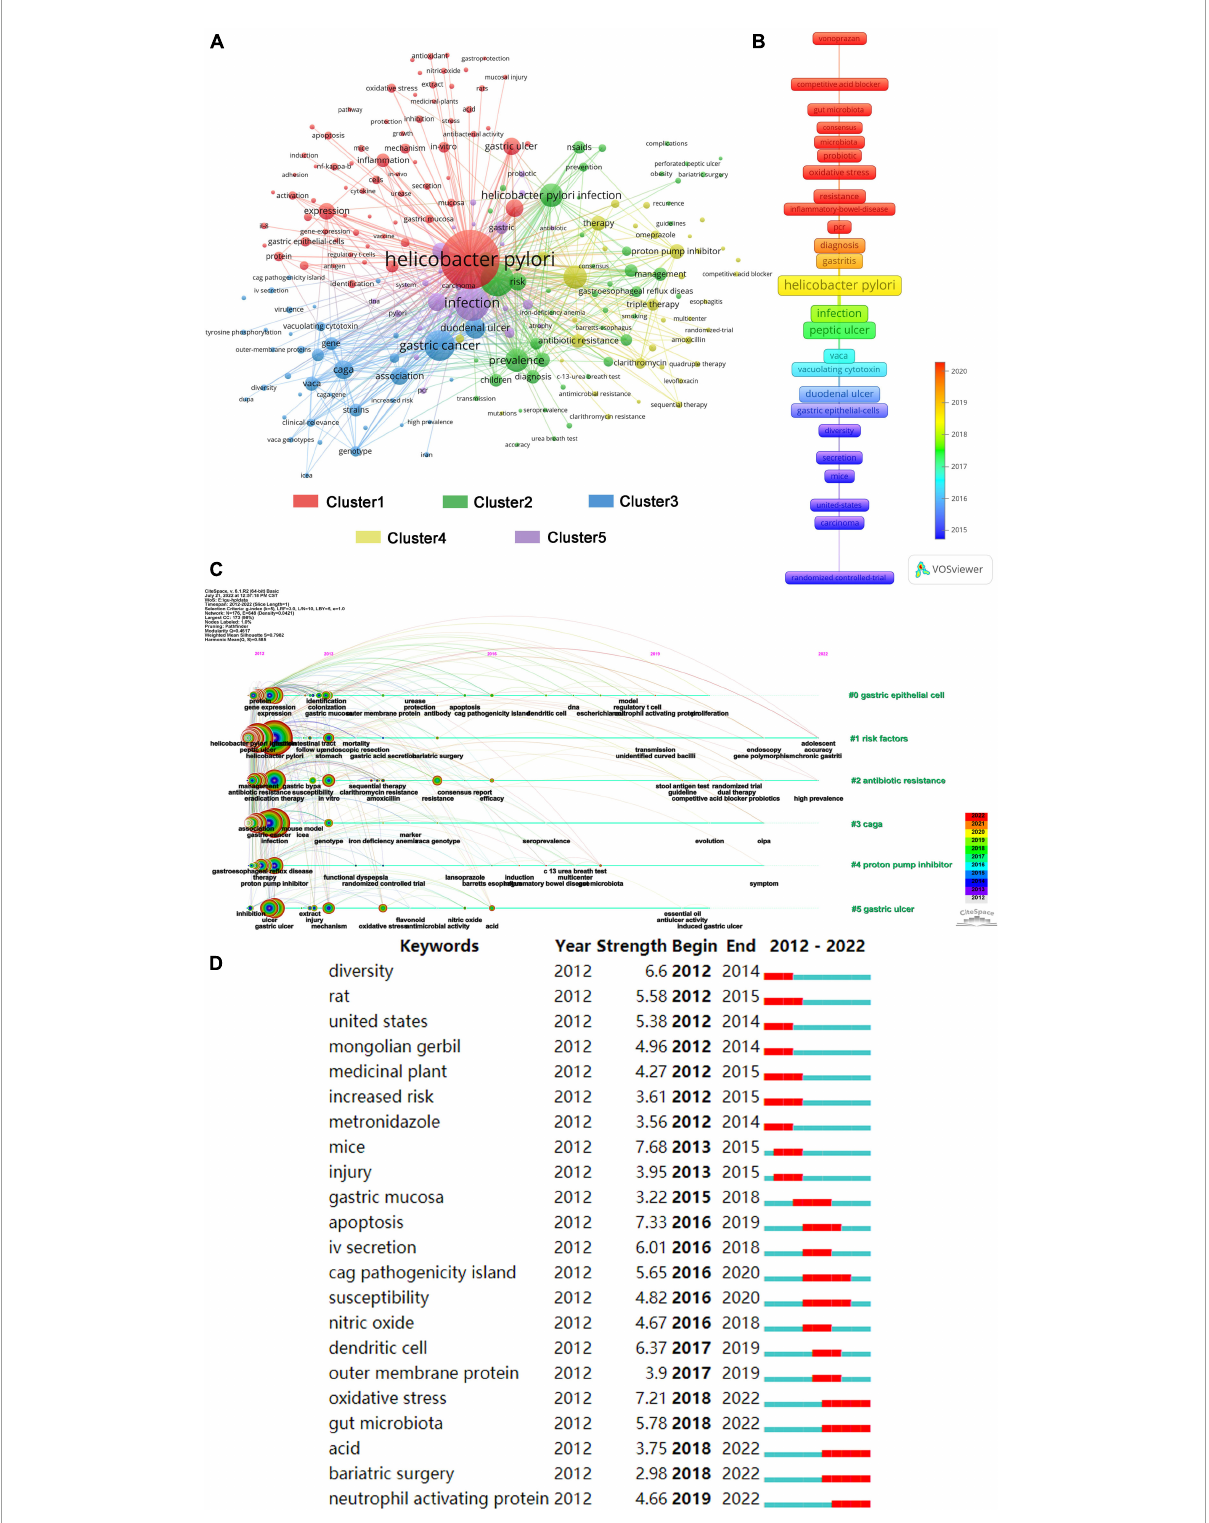
FIGURE9 Keywords map for Helicobacter pylori -related gastric ulcer (GU). (A) The keyword co-occurrence network that displays the clustering of keywords through different colors, and the same color indicates that these keywords were in the same cluster. (B) The graph of the average year in which keywords appear, with red keywords appearing later than dark blue. (C) Keyword clustering timeline graph. (D) Top 22 keywords with the most